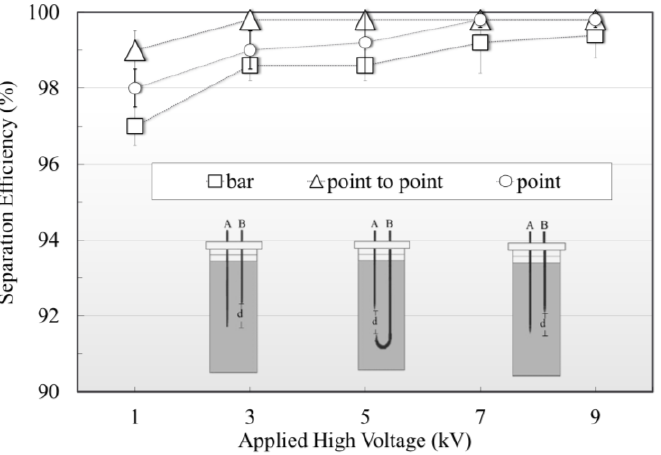
Figure 10. Effect of applied AC high voltage with different electrode configurations on the separation efficiency of the EDS process using iron (Fe) electrodes with vertical distance between electrodes of 3 cm (d = 3 cm) for separation time of 240 s. (A = High voltage electrode and B = Ground electrode)